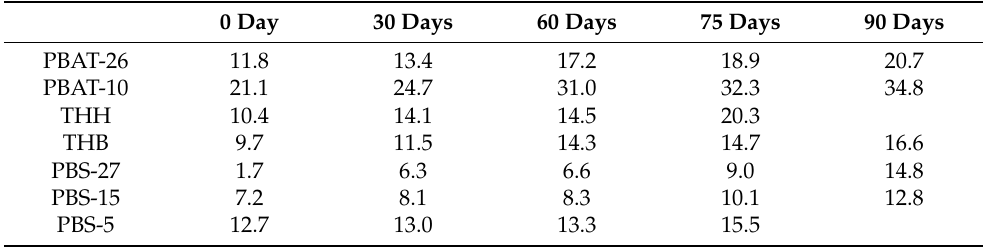
Table 1. The X c (%) of PBAT and PBS in mulching films before and after